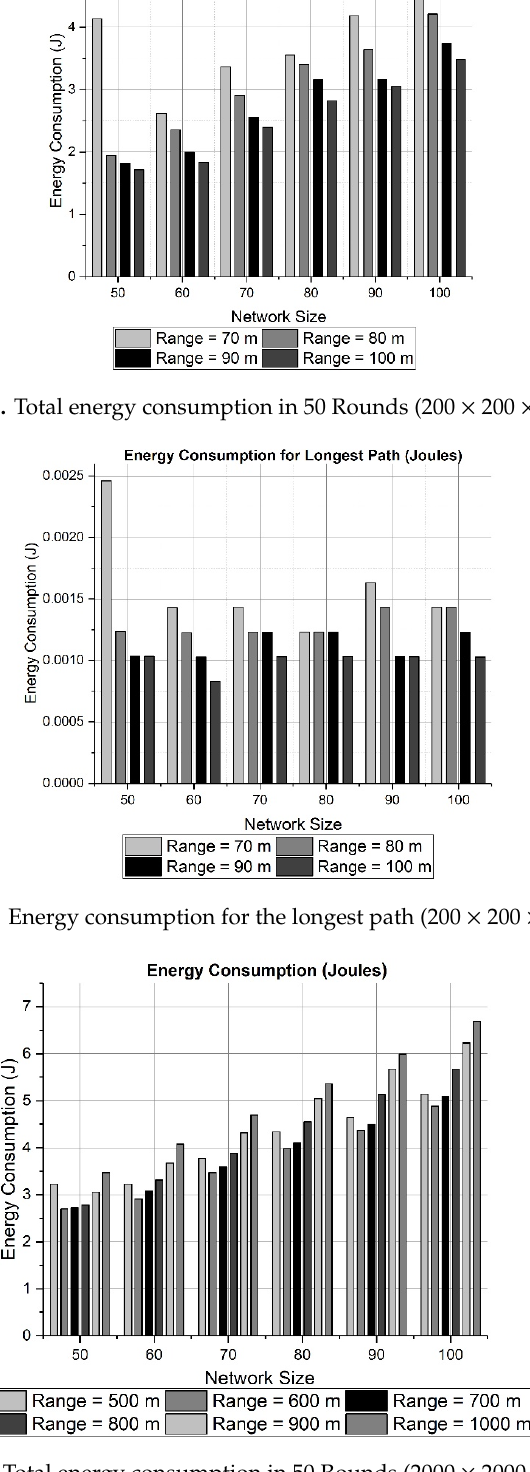
Figure 13. Energy consumption for the longest path (2000 × 2000 × 500 m). 5.2. Faulty Tolerance Because of random deployment of nodes, if a node has N number of neighbors. It will have at least N number of possible paths leading to the sink. Among the available paths, the one with smallest hop count and shortest distance to sink is considered an optimal path while others are alternate. Alternate path is the best possible route available after optimal path, selected based on the path selection criterion when fault is detected. To further evaluate the fidelity of SOSRP, a fault probability of 0.2 is realized, e.g., in case of 5000 optimal paths found, only 1000 pragmatic paths will be detected. In multi-hop communication, it is desirable to keep the hop count minimum in the path to limit the end-to-end delay and the energy consumption. The results obtained compare the total number of paths generated by SOSRP with number of hops in each path for optimal and pragmatic behavior of protocol. The results are shown in Figures 14–15. In Figure 14 the number of hops in the route is shown for a network size of 50 nodes, and 100 nodes in the case of Figure 15.